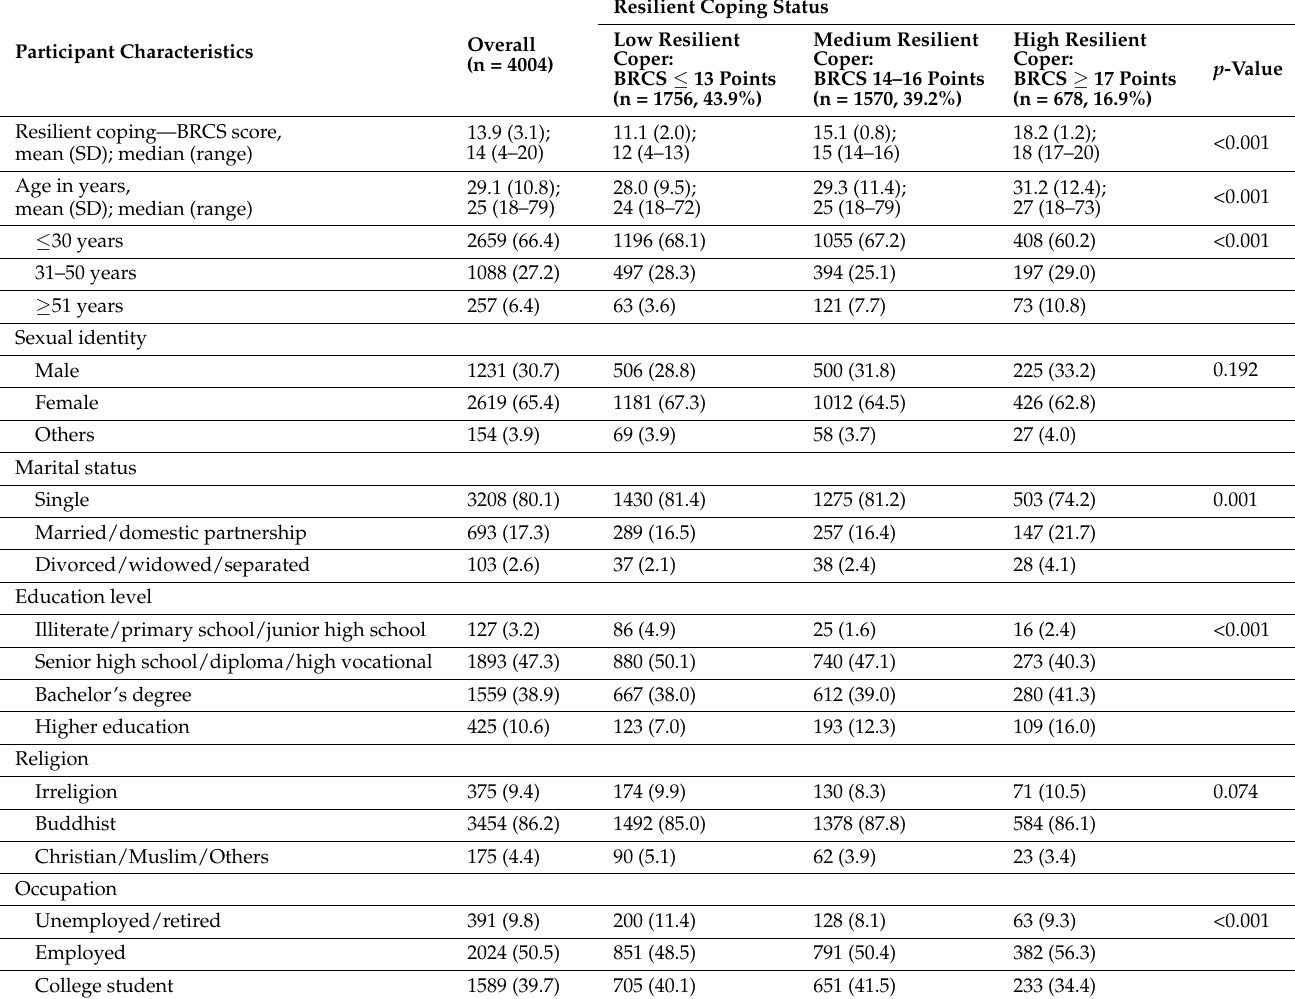
Table 2. Participant characteristics and the resilient coping status in Thailand †